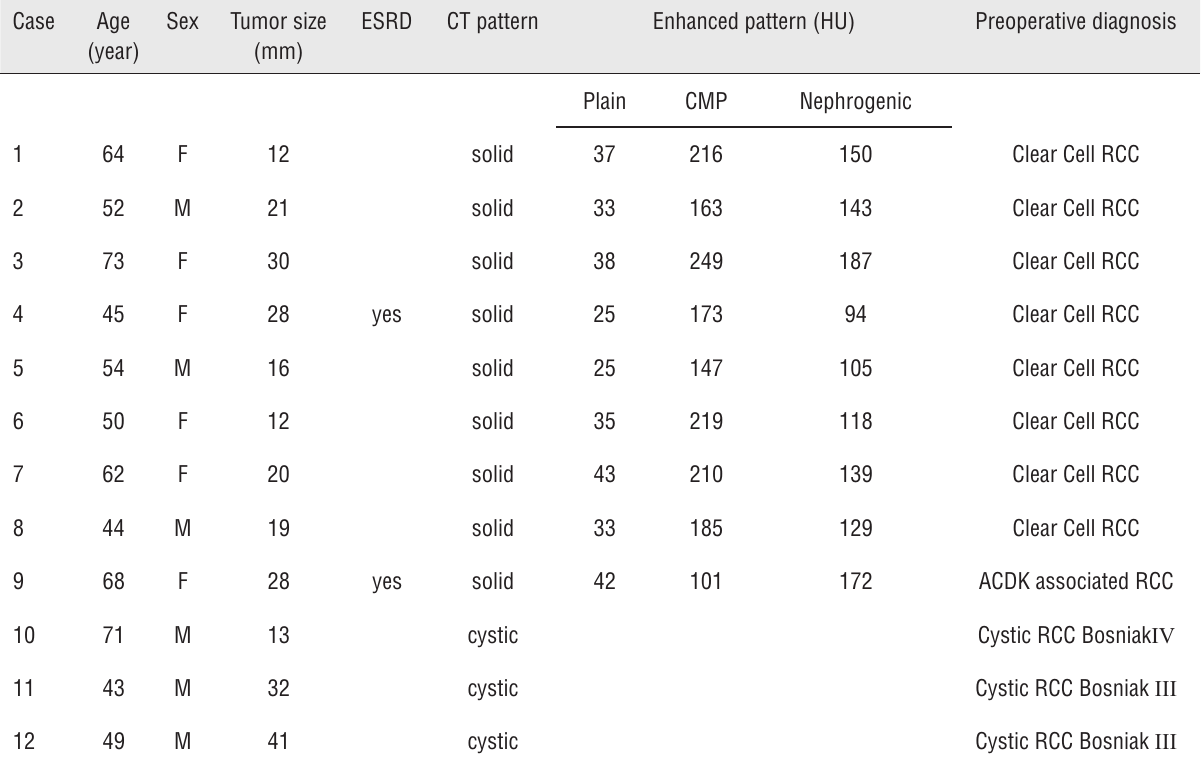
Table 2. CT imaging characteristics of clear cell papillary renal cell